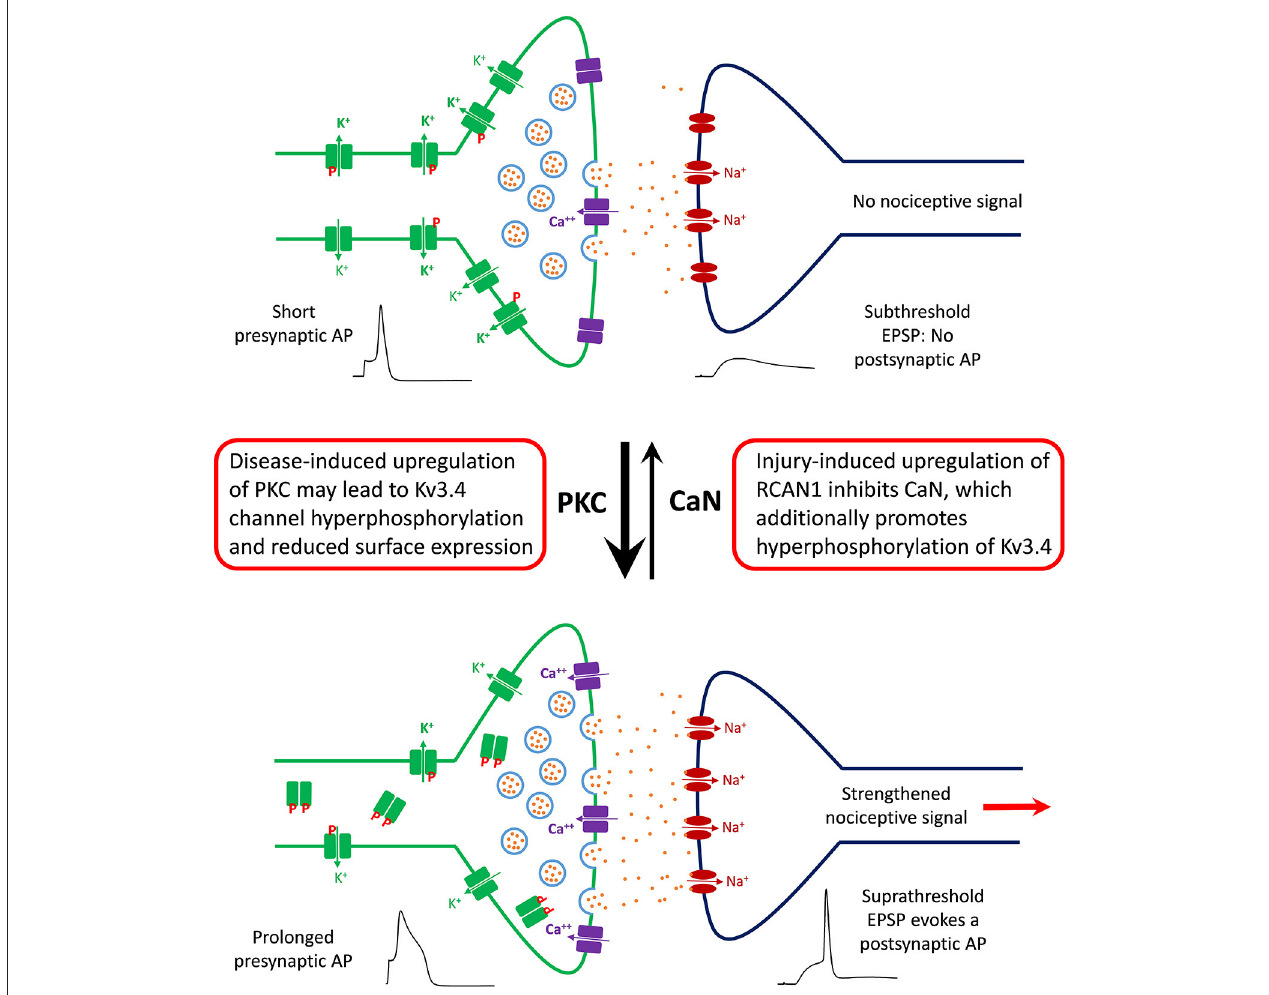
FIGURE 5 | Working model of the role of DRG Kv3.4 channels in nociception and neuropathic pain at the level of the first synapse in the dorsal horn. Under homeostatic conditions, Kv3.4 channels (green blocks) in DRG neurons might play an antinociceptive role by limiting excitatory neurotransmission in the superficial dorsal horn. Kv3.4 channels keep presynaptic excitability in check by regulating AP duration and thereby limiting vesicular Ca ++ -dependent glutamate release. Phosphorylated Kv3.4 channels have an enhanced ability to play this role because they exhibit reduced N-type inactivation. However, following an injury (e.g., SCI and SNL), various factors (inflammation, maladaptive cellular changes, serotonin spillover, etc.) might lead to hyperactivation/upregulation of PKC and inhibition of CaN. Thus, Kv3.4 channels may become hyperphosphorylated, which reduces its presence on the cell membrane of DRG neurons. Consequently, the presynaptic AP